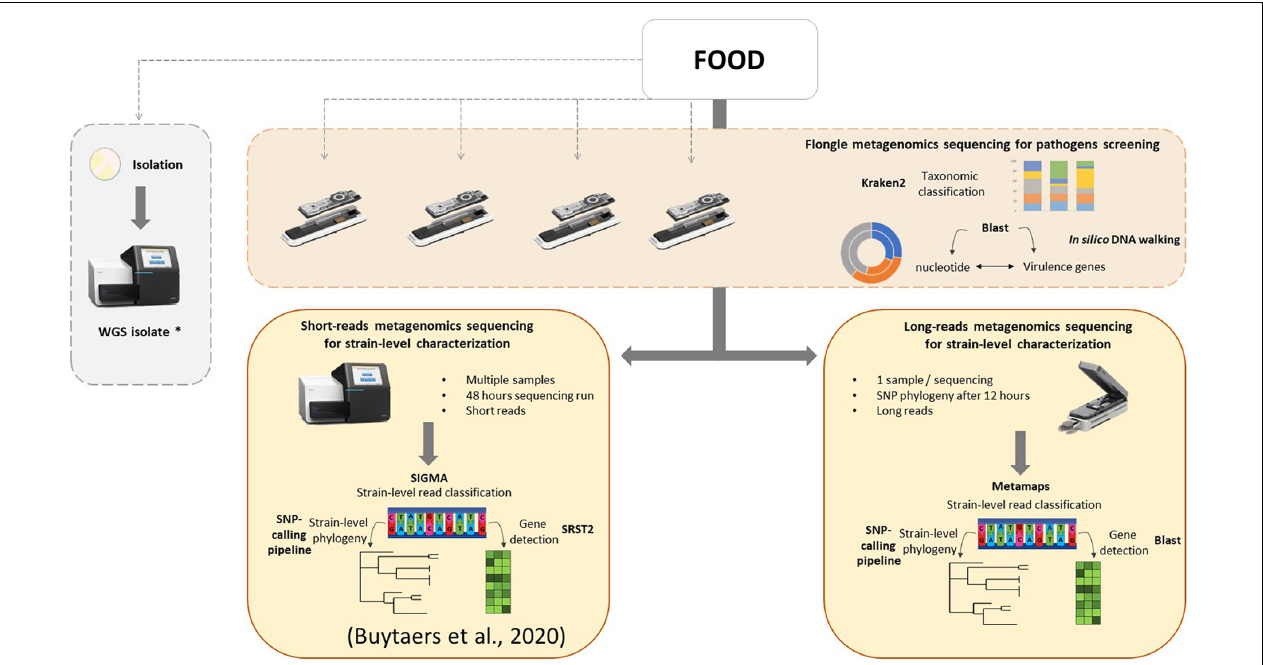
FIGURE 5 | Integrated metagenomics-based strategy for microbiological foodborne outbreak investigation. As first optional steps, food samples can be screened for the presence of bacterial pathogens using metagenomics Flongle sequencing, taxonomic classification, and in silico DNA walking (based on BLAST to the nucleotide database and virulence genes database) in parallel with the ongoing attempt to isolate the pathogen, followed by WGS of the obtained isolates. A strain-level characterization can be attempted from the Flongle sequencing or conducted after using an Illumina strategy (more cost-effective for multiple samples) or a MinION strategy (fast response for one sample) in food samples for which the presence of a pathogen is confirmed. The strain-level data analysis for Illumina sequencing was previously presented Buytaers et al. (2020). The strain-level data analysis workflow for MinION sequencing is based on classification using Metamaps, a gene detection with BLAST, and phylogenetics with a SNP-calling pipeline. The asterisk (*) indicates that WGS isolate data is interesting to feed to reference genome databases for the classification of the metagenomics reads for future analyses.